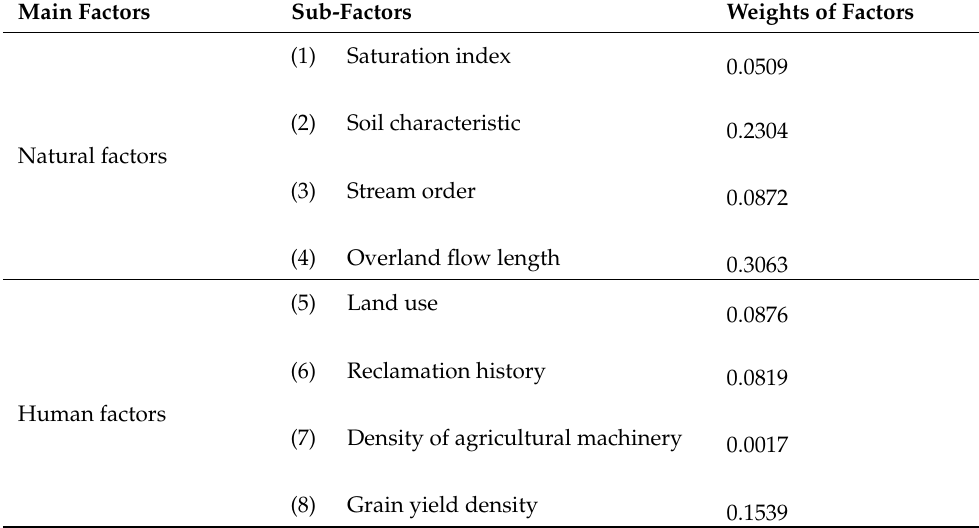
Table 1. Weights of factors related to wetland restoration.